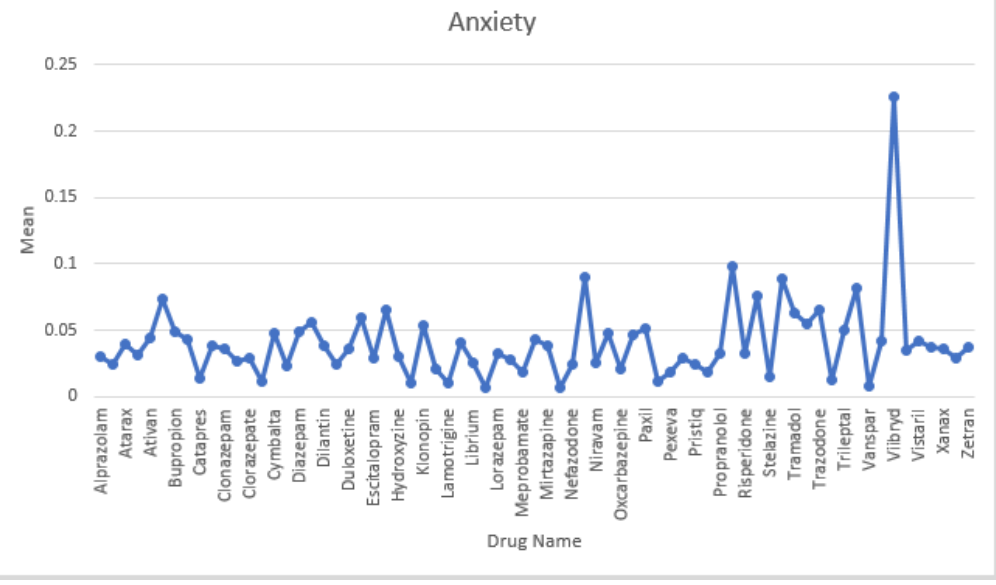
Figure 20. Drug recommendation results against anxiety disease condition query.